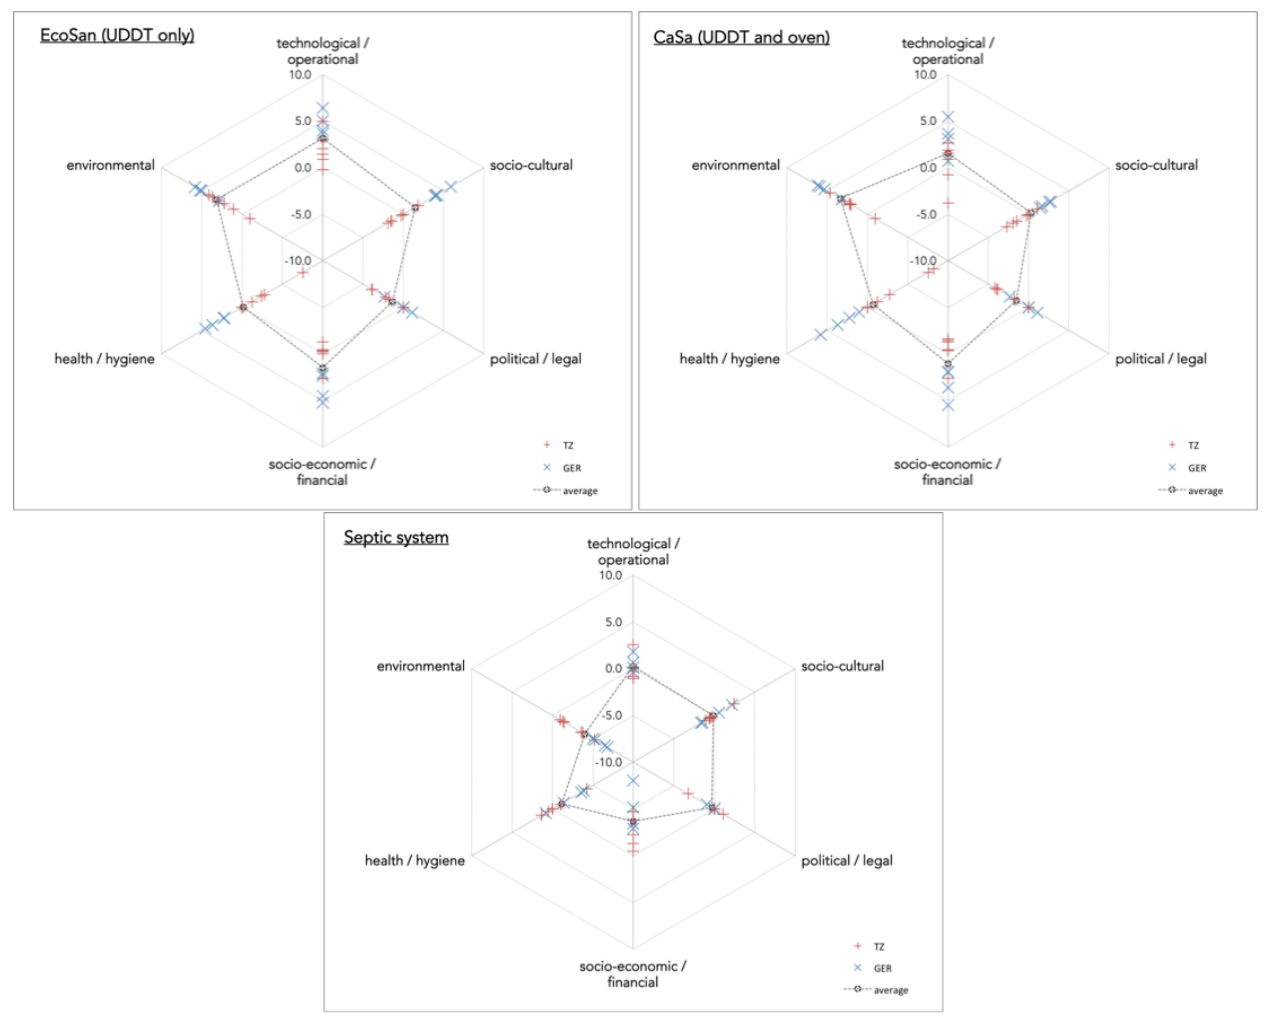
Figure 7. Colour-coded scatter plot for the three sanitation alternatives analysed (EcoSan, CaSa, and septic system) indicating the assessment results of Tanzanian (red) and German participants (blue) alongside the mean of all participants (grey). Results are shown on the level of the six main-criteria. Values range from − 10 to + 10 (cf. Table 4).